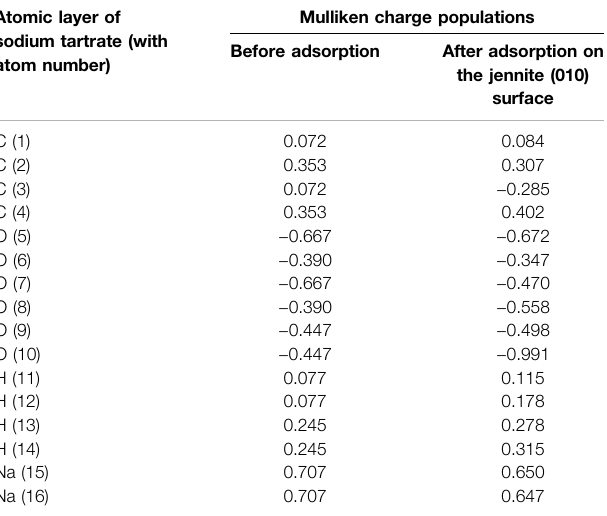
TABLE 7 | The comparison of Mulliken charge populations for sodium tartrate before and after adsorption. Atomic layer of sodium tartrate